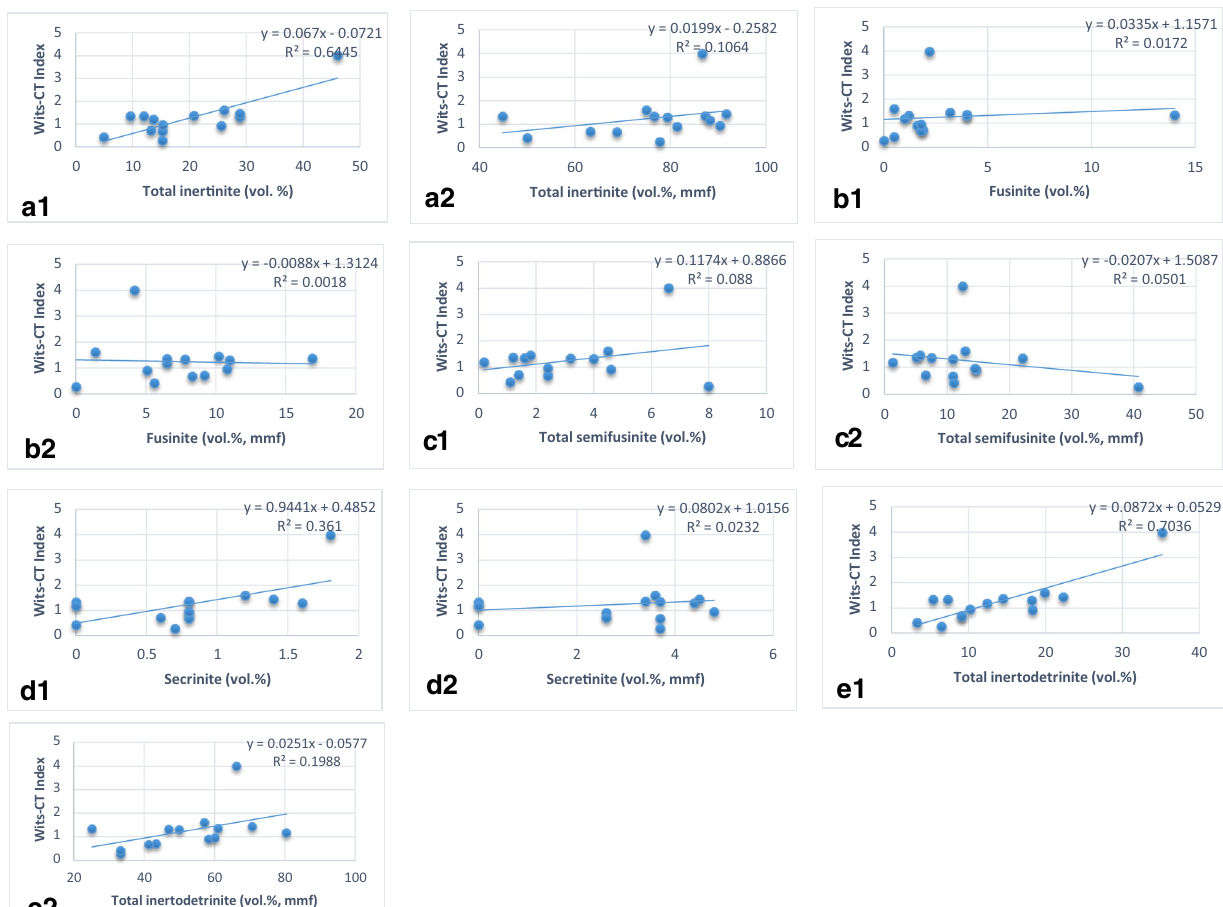
Fig. 12 Influence of inertinite and its group on spontaneous combustion of